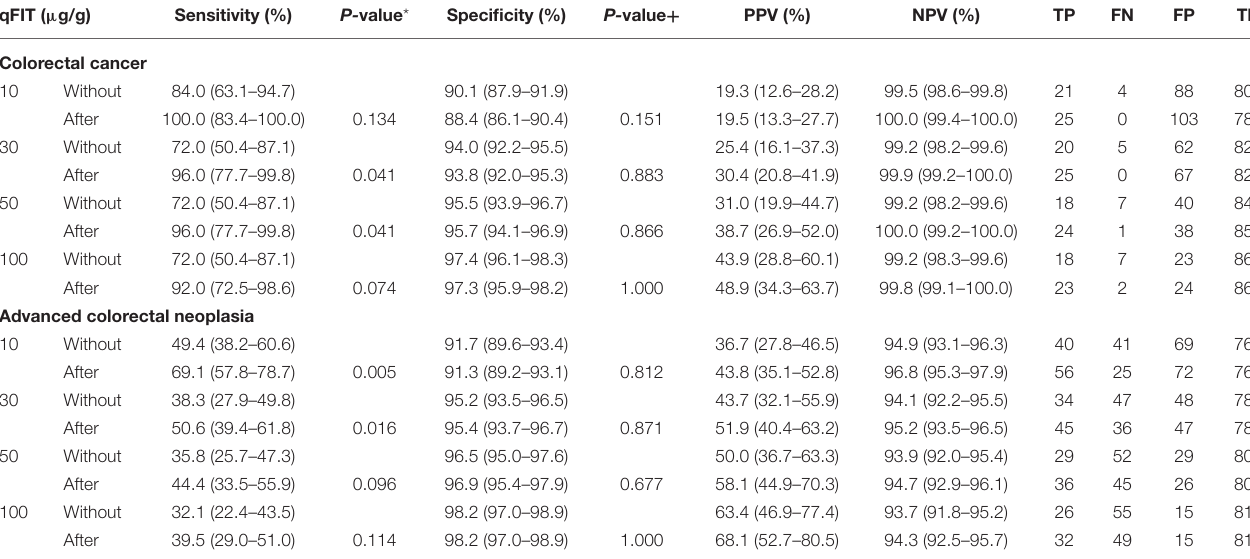
TABLE 2 | Performance characteristics of the quantitative fecal immunochemical test (qFIT) without and after the practical sample collection operant training for colorectal cancer (CRC) and advanced colorectal neoplasia